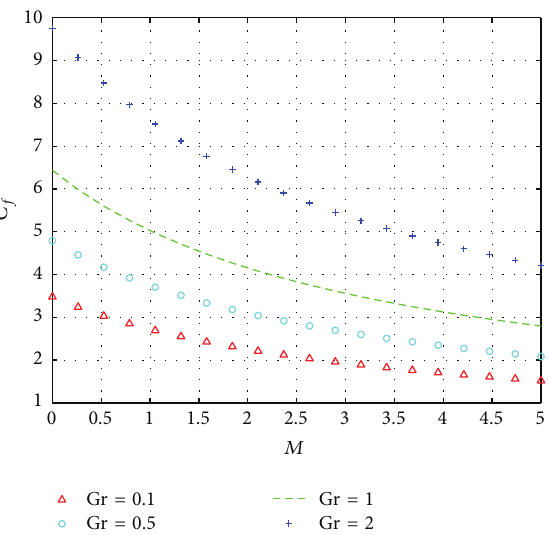
Figure 10: Variation of all shear stress magnetic field; 𝑡 = 50